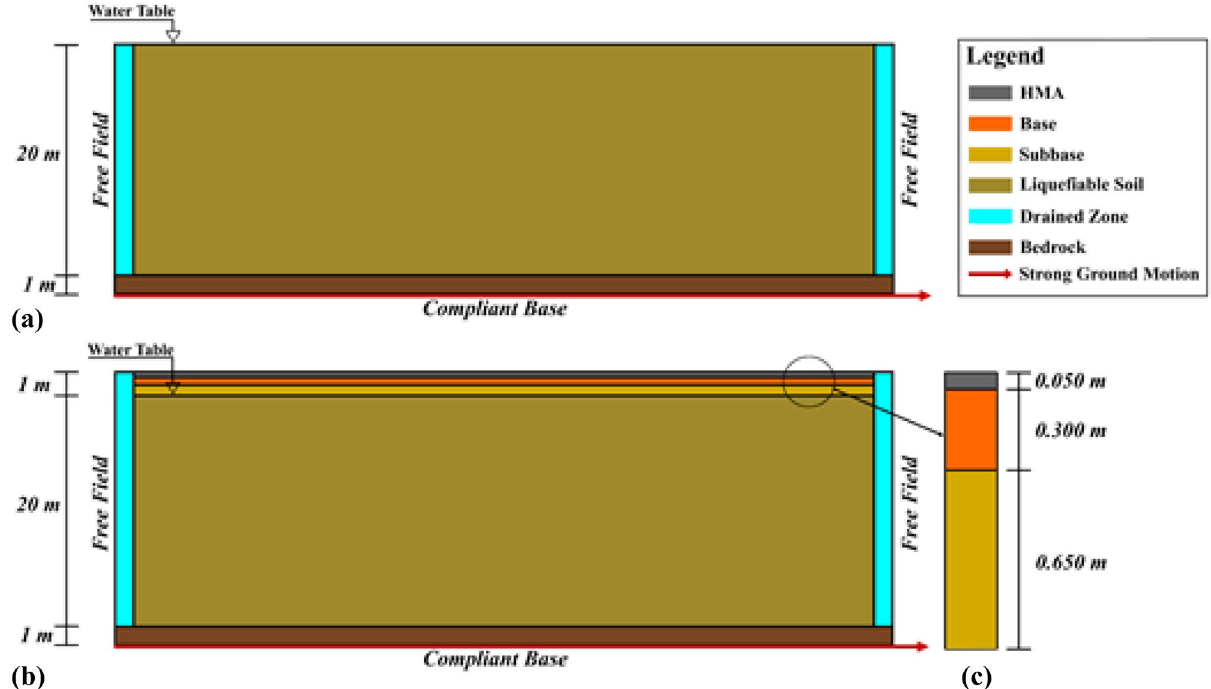
Figure 11. Numerical Models ( a ) Model 1, ( b ) Model 2 and Model 3, ( c ) soil profile of pavement (not scaled).